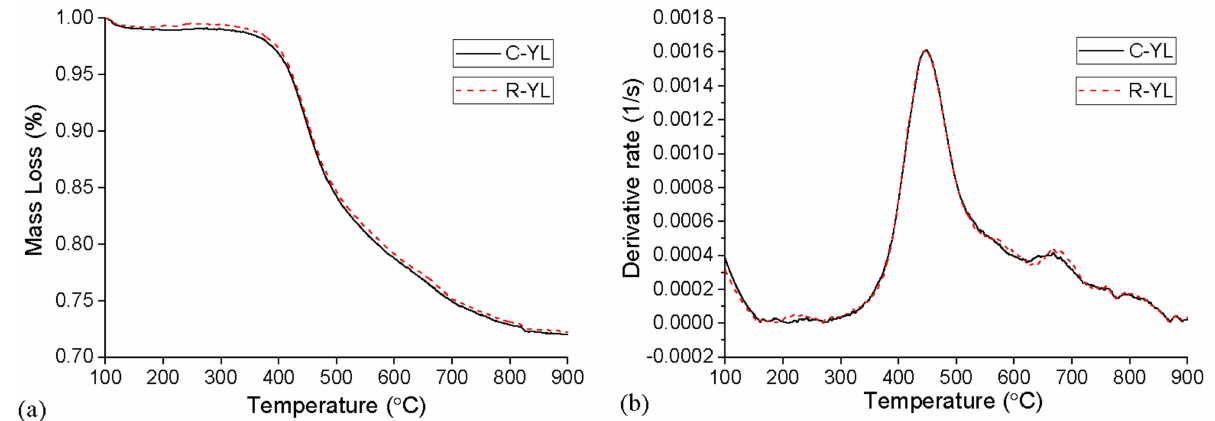
Figure 6. Comparison of R-YL and C-YL in TGA, 10 K/min, 1 bar, ( a ) TG, ( b )